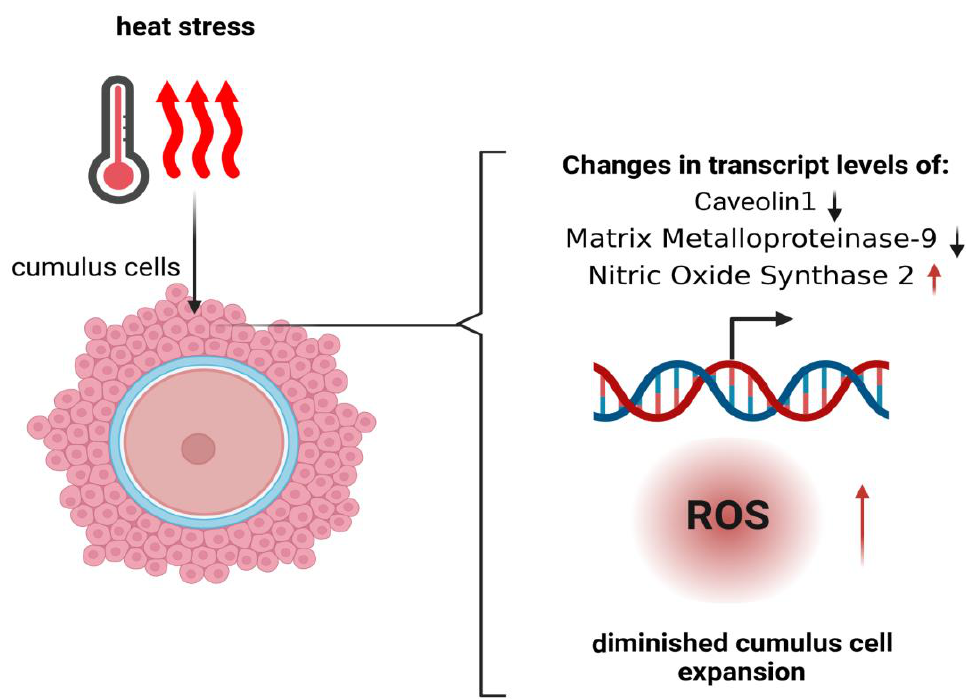
Figure 2. Scheme showing the impact of heat stress on cumulus cells on transcript levels, reactive oxygen (ROS) levels inside cumulus cells, and the expansion of cumulus cells, which is crucial during oocyte maturation.